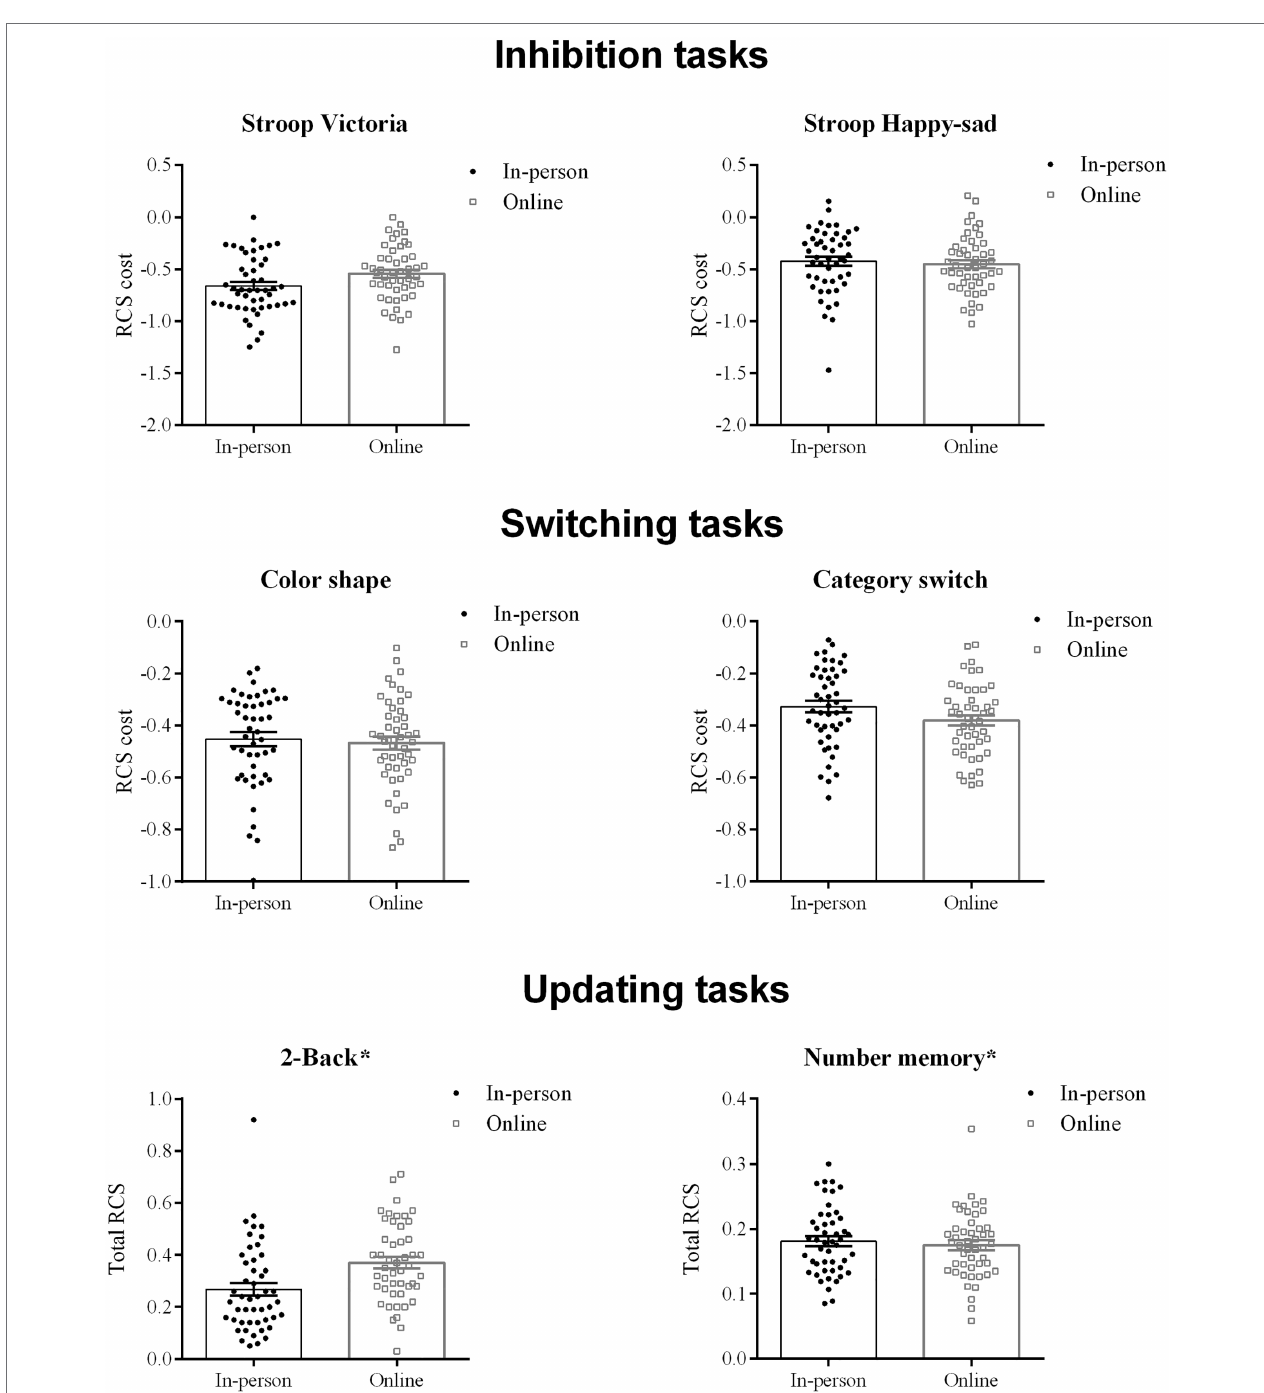
FIGURE 2 | Individual (dots) and mean (±SE) scores (histograms with error bars) per type of test administration [participants tested in person (black circles) and online (open grey squares)] in each of the executive function measures. *data shown without correction for